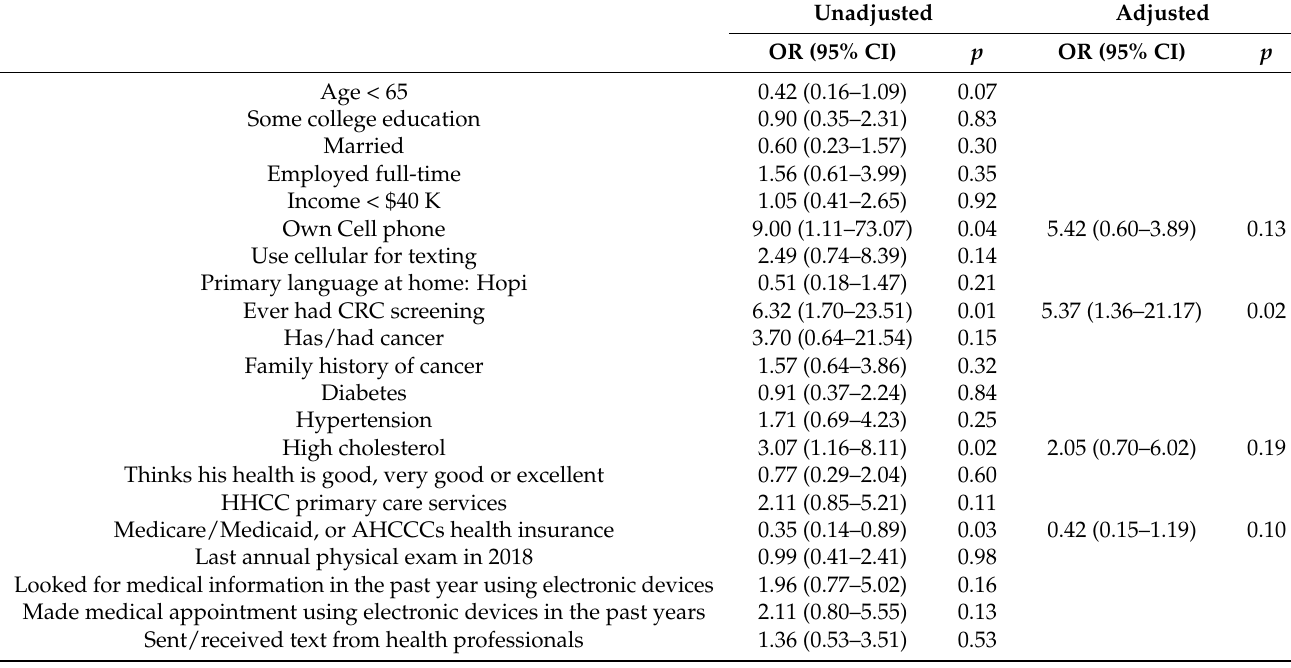
Table 4. Identification of factors associated with having PCa screening for Hopi men with age ≥ 50.